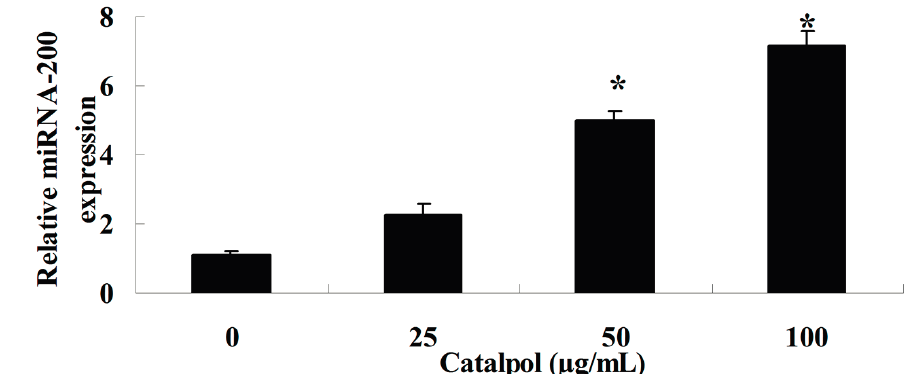
Figure 5. Catalpol induced miR-200 expression. * p < 0.01 compared with 0 mg/mL catalpol treatment